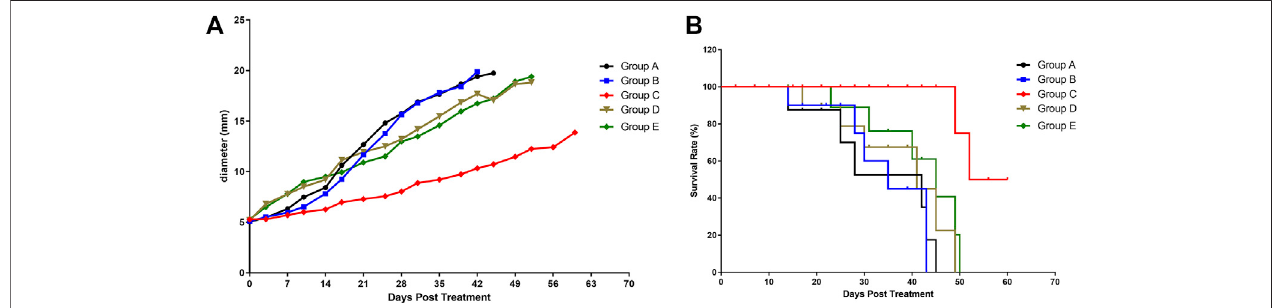
FIGURE 2 | Tumor growth and mice survival in different mice groups. (A) Effect of the various treatments on tumor growth. (B) Effect of the various treatments on follow-up survival of mice ( n (cid:2) 6/group). Group A, blank control (black curve), group B, NET-1 siRNA nanoparticles without LIFU irradiation (blue curve); group C, NET-1 siRNAnanoparticleswithLIFUirradiation(redcurve);groupD,NC-siRNAduplexnanoparticleswithLIFUirradiation(browncurve);andgroupE,blanknanoparticleswith LIFU irradiation (green curve).